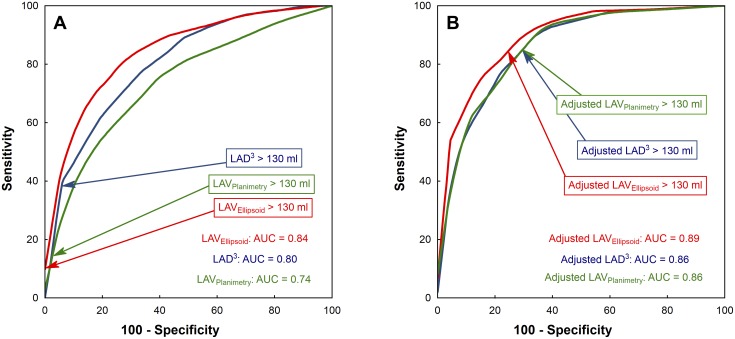
Receiver operating characteristics (ROC) for the prediction of CARTO-derived LAV > 130 ml.ROC curves are plotted for LAD3 (in blue), LAVEllipsoid (in red) and (3) LAVPlanimetry (in green). Panel A: ROC for raw 2D-ECHO-based LAV. Panel B: ROC for multivariately adjusted 2D-ECHO-based LAV (the adjustment was the same as in Fig 4). Points corresponding to 2D-ECHO-based LAV > 130 ml are indicated by arrows. AUC—area under the curve; other abbreviations as in Fig 1.